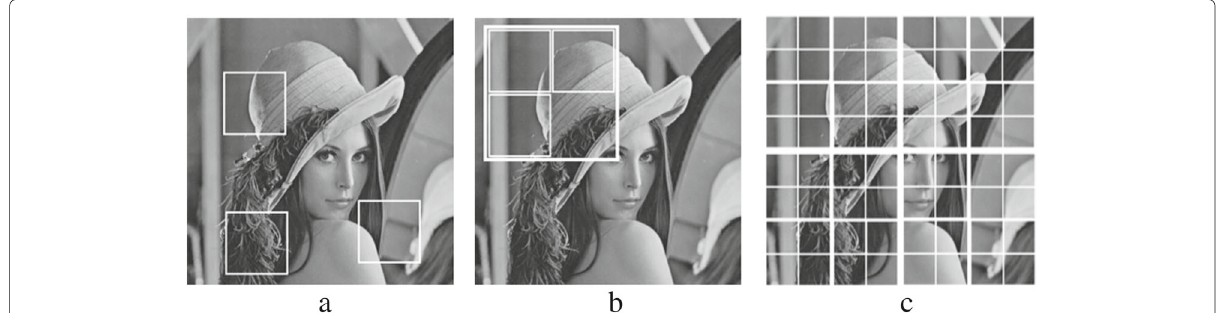
Fig. 8 Collecting a set of patches in PB-PCA filtering: a global PCA, b local PCA, and c hierarchical PCA